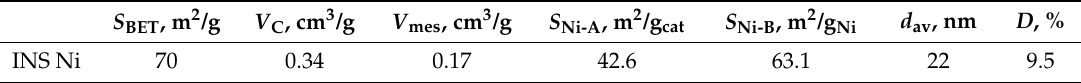
Table 1. Physicochemical properties of the precursor.